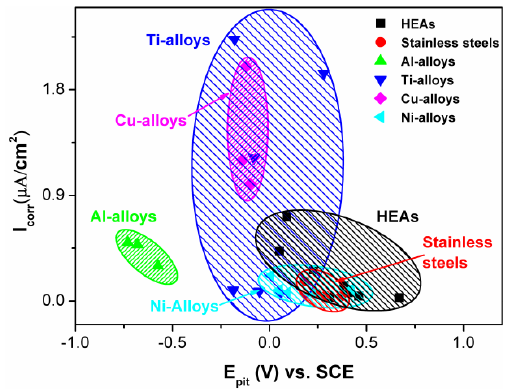
Figure 4. A comparison of the corrosion current density ( i corr ) and pitting potential ( E pit ) between HEAs and other materials in the 3.5 wt % NaCl solution at room temperature.